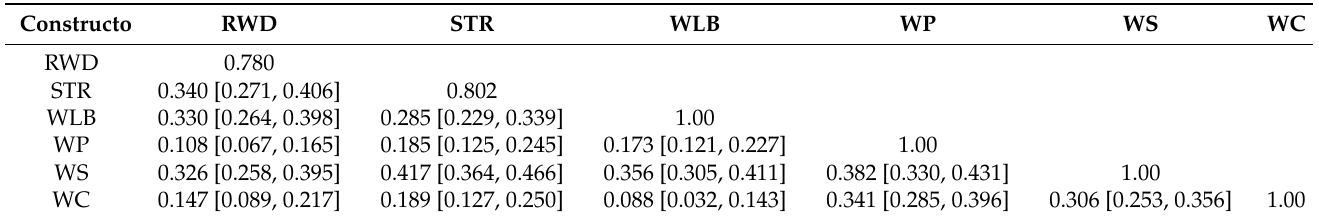
Table 2. Discriminant validity evaluation of the measurement model using HTMT.